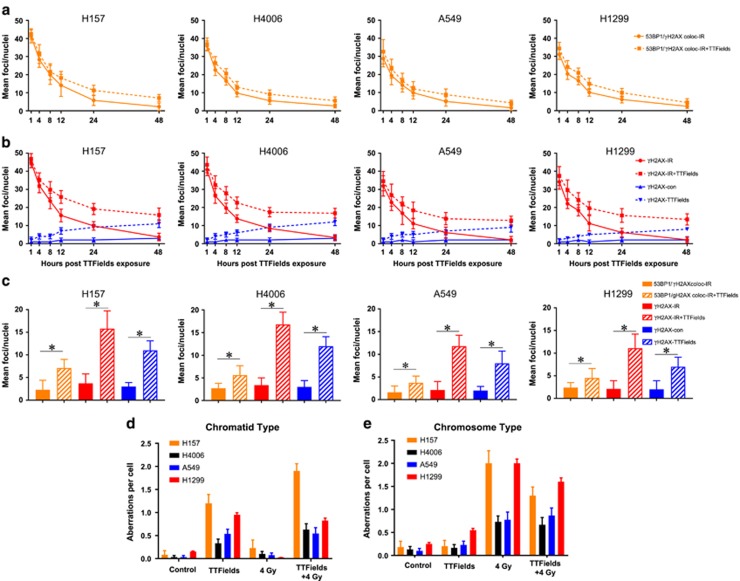
TTFields induce DNA damage and slow the repair of IR-induced DSBs. (a) Changes in the mean number of localized 53BP1 and γ-H2AX foci over 48 h. (b) Change in the mean number of γ-H2AX foci over time with TTFields alone (blue lines) and after receiving 2 Gy (red lines), both followed over 48 h. (c) The mean value for residual γ-H2AX foci and localized 53BP1 and γ-H2AX foci at 48 h post-IR for all cell lines. (d) TTFields exposure for 48 h resulted in the induction of chromatid-type aberrations in the panel of NSCLC lines. (e) The frequency of chromosome-type aberrations after a 48 h TTFields exposure in combination with radiation. Error bars represent the S.E.M. of three separate experiments and asterisks represent significant difference (P<0.05) between indicated conditions